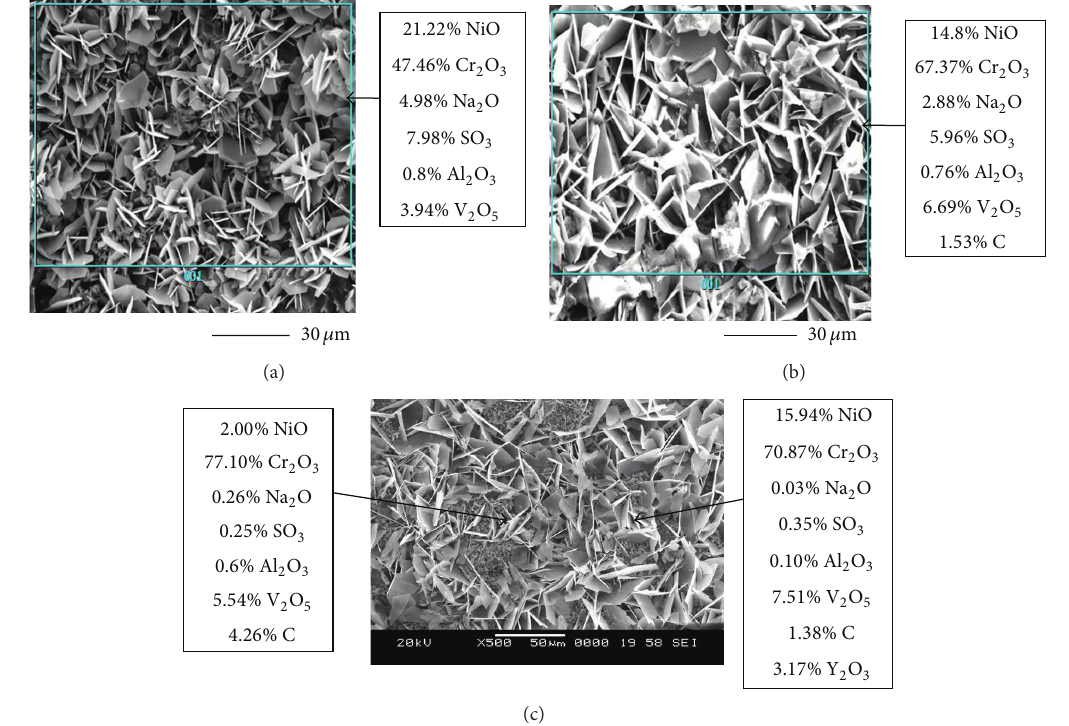
Figure 11: SEM and EDX analysis of 25% (Cr 3 C 2 -25(Ni20Cr)) + NiCrAlY coated materials subjected to hot corrosion for 50 cycles in Na 2 SO 4 + 50%V 2 O 5 at 800 ∘ C. (a) Ti-31, (b) Superco-605, and (c)